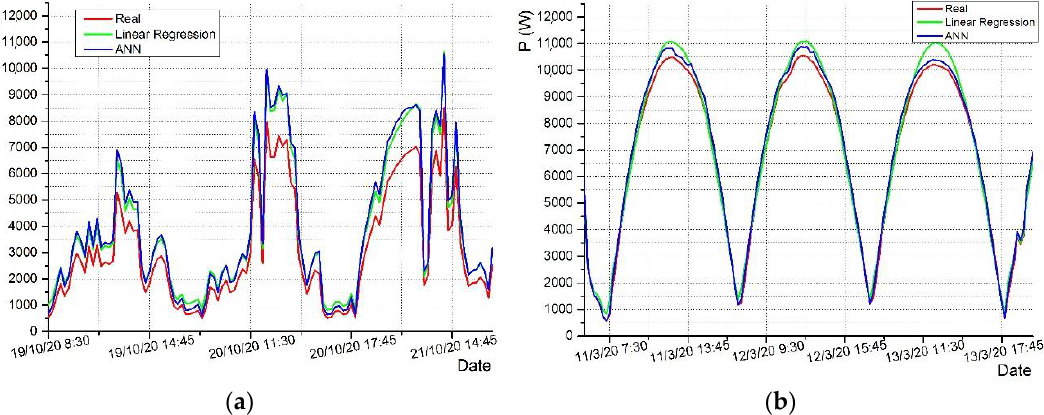
Figure 13. Comparison between real power output and two models forecasting for three cloudy ( a ) and three sunny days ( b ) for 2020.